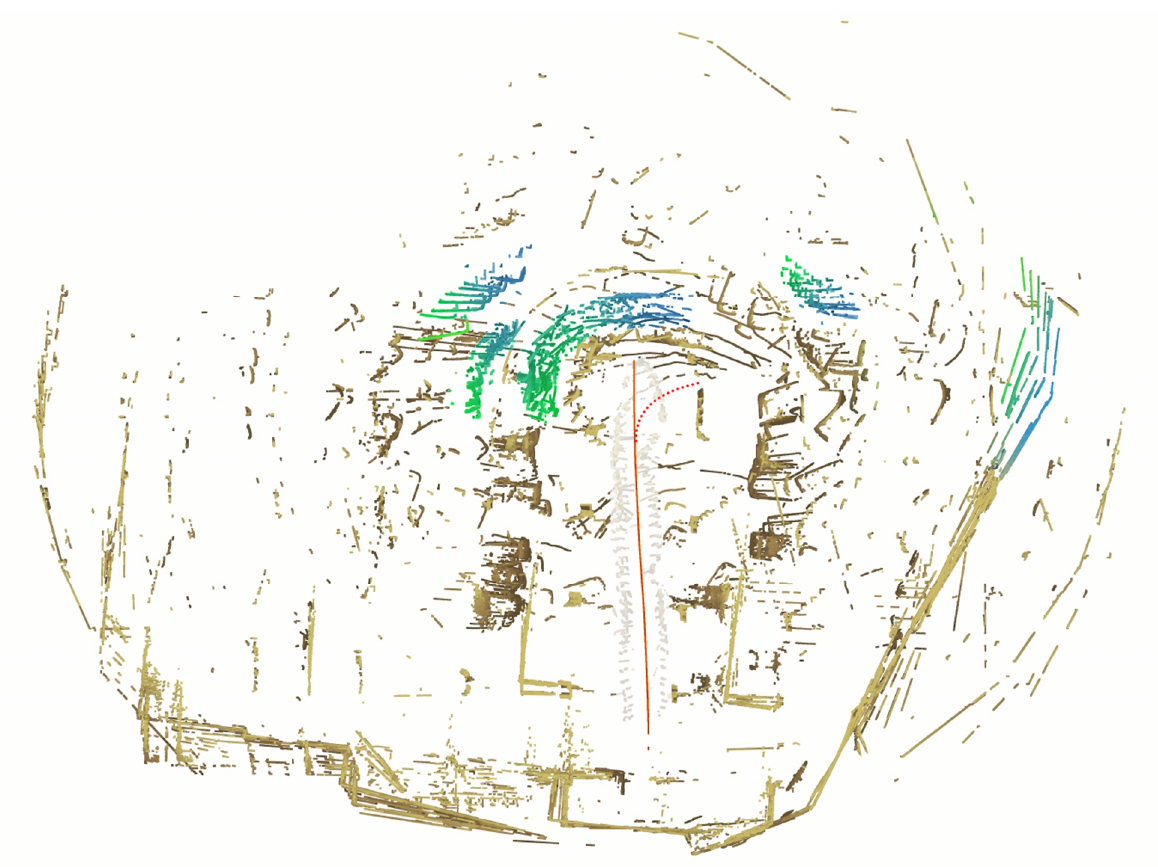
Figure 7. An attempt to correct a steep curve fails. The point cloud is shown from the top with the floor and the ceiling removed. The computed trajectory is plotted in red. The location of the actual trajectory is manually approximated with a dotted red line, and differs from the computed trajectory. Therefore, the walls and objects are displaced by a counter-clockwise rotation. We have colored some of them for visualization purposes with the color fading from green (displaced data) to blue (correctly placed data). However, the trajectory is successfully corrected in the lower part of the image, where the curvature is low enough in both the horizontal and the vertical